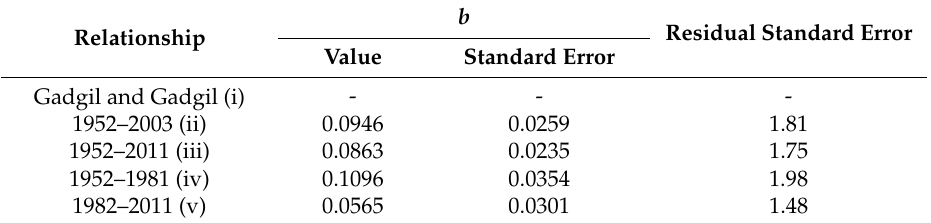
Table 3. As Table 2 but for a linear fit model of the relationship between ISMR and GDP (i.e., the values for a are